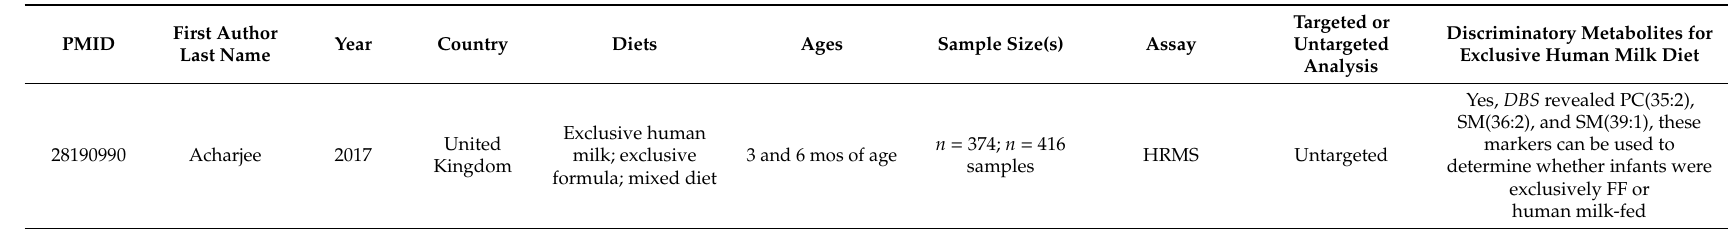
Table 2. Manuscripts reporting plasma / serum and dried blood spot metabolites from human milk- and / or formula-fed infants ( n =